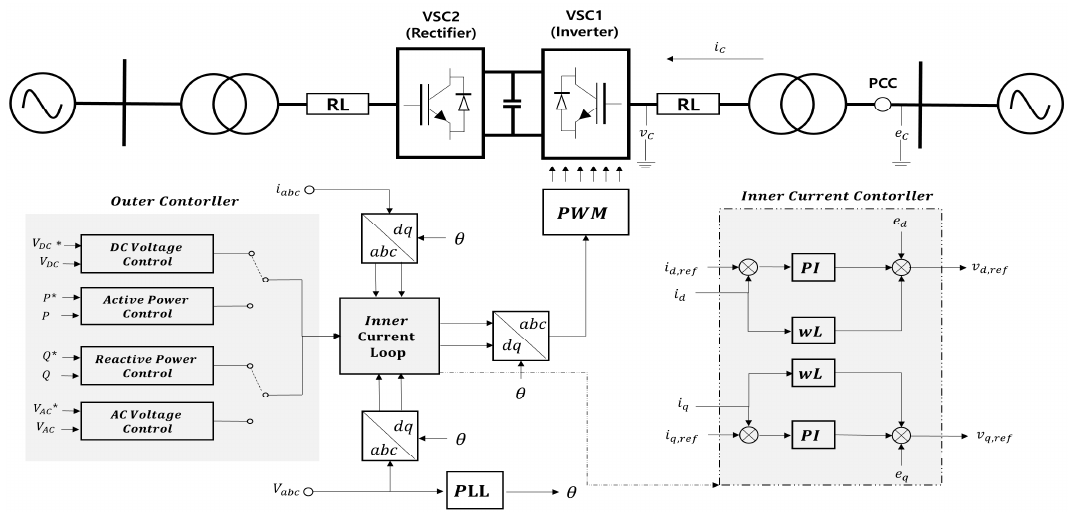
Figure 1. The voltage source converter (VSC) high-voltage direct-current (HVDC) system configuration.